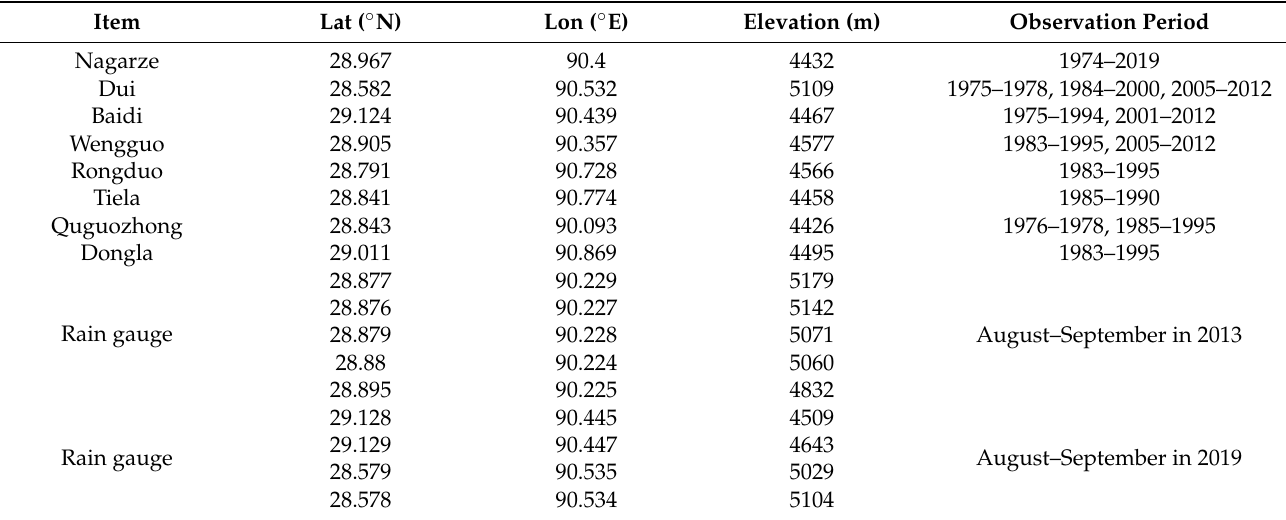
Table 2. Description of the precipitation observation